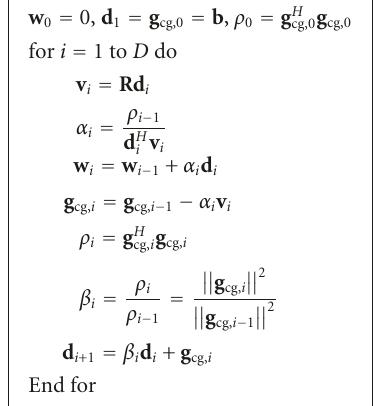
Algorithm 1: Basic conjugate gradient